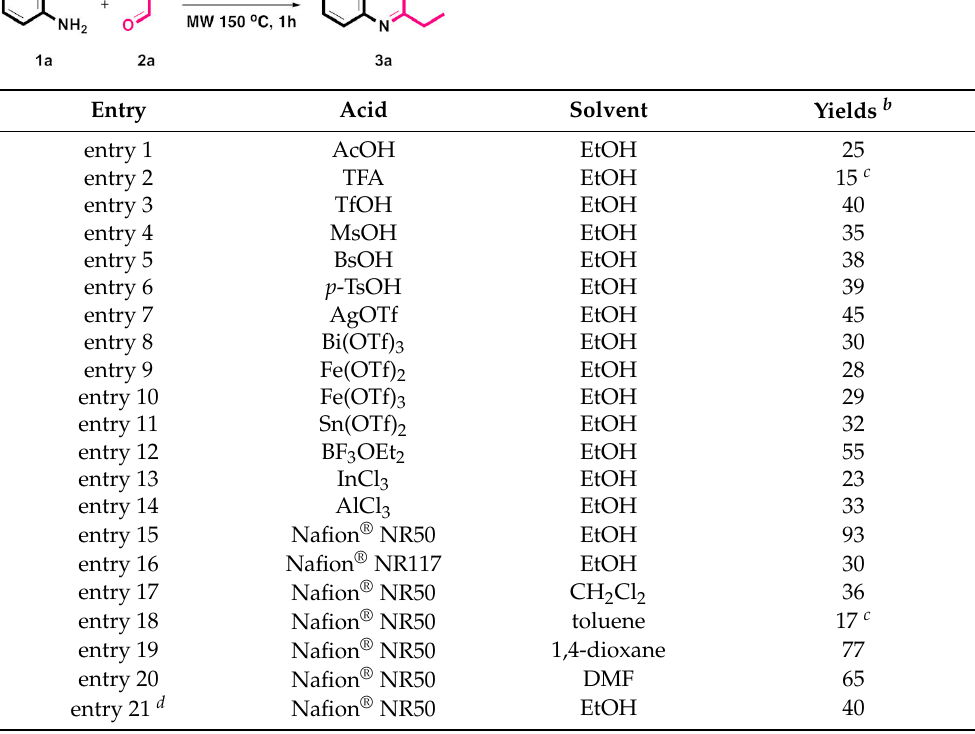
Table 1. Optimization of the reaction conditions a